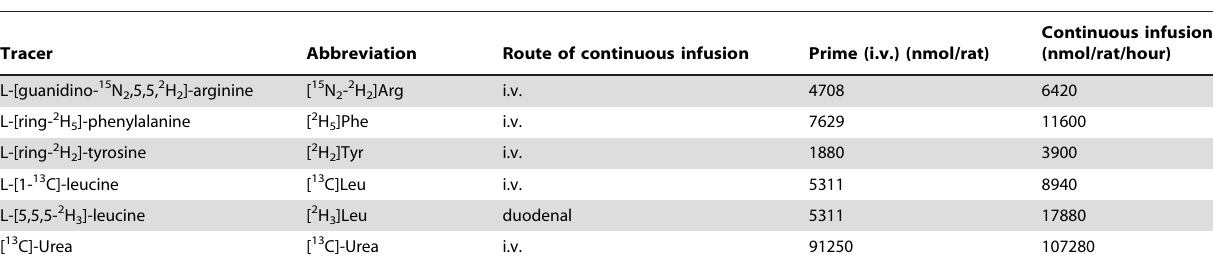
Table 2. Tracer prime and infusion rates.